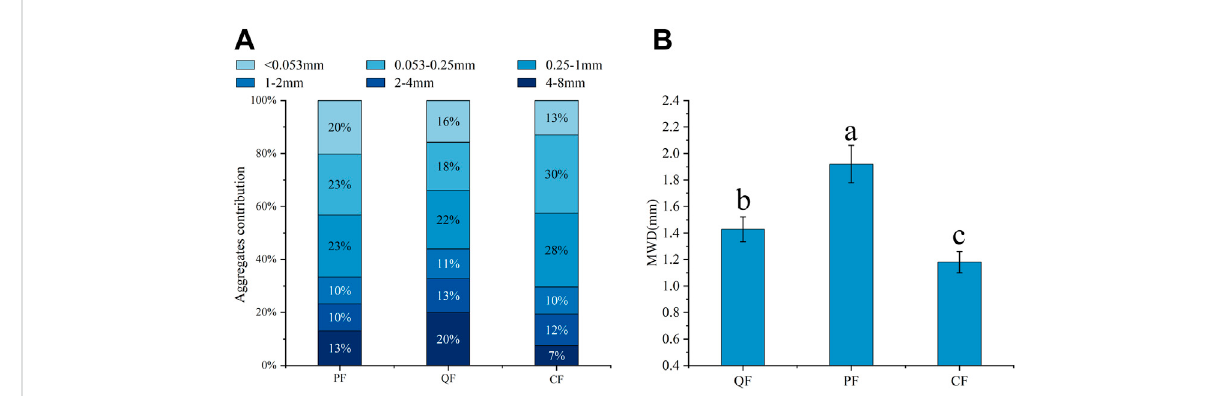
FIGURE 1 Particle size composition of different forest types. Note: lowercase letters indicate a signi fi cant difference in the MWD between different forest types. Different blue gradient indicate the number of aggregates with different particle